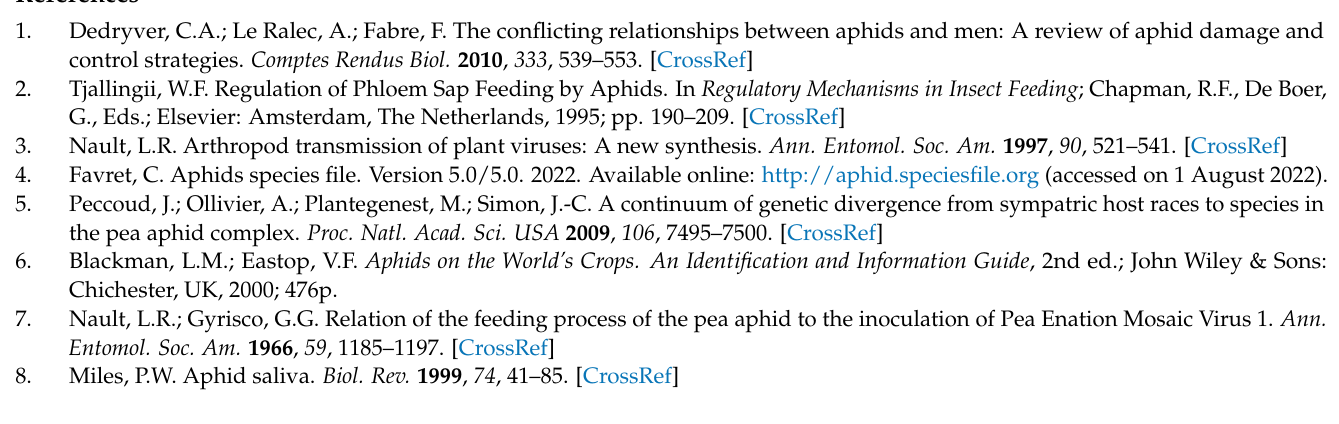
tions using the yeast two-hybrid system; Figure S2: Production of mature Mp10 proteins in E. coli ; Table S1: Feeding behavior of M. persicae adults previously fed for 72 h on siRNA targeting stylin-01 or stylin-03 gene recorded on Arabidopsis thaliana . Non-sequential EPG variables; Table S2: Feeding behavior of M. persicae adults previously fed for 72 h on siRNA targeting stylin-01 or stylin-03 gene recorded on Arabidopsis thaliana . Sequential EPG variables; Table S3: List of oligonucleotides used in this study; Supplementary information: Material and Methods, modification of original plasmids to construct pLexAN-GG &